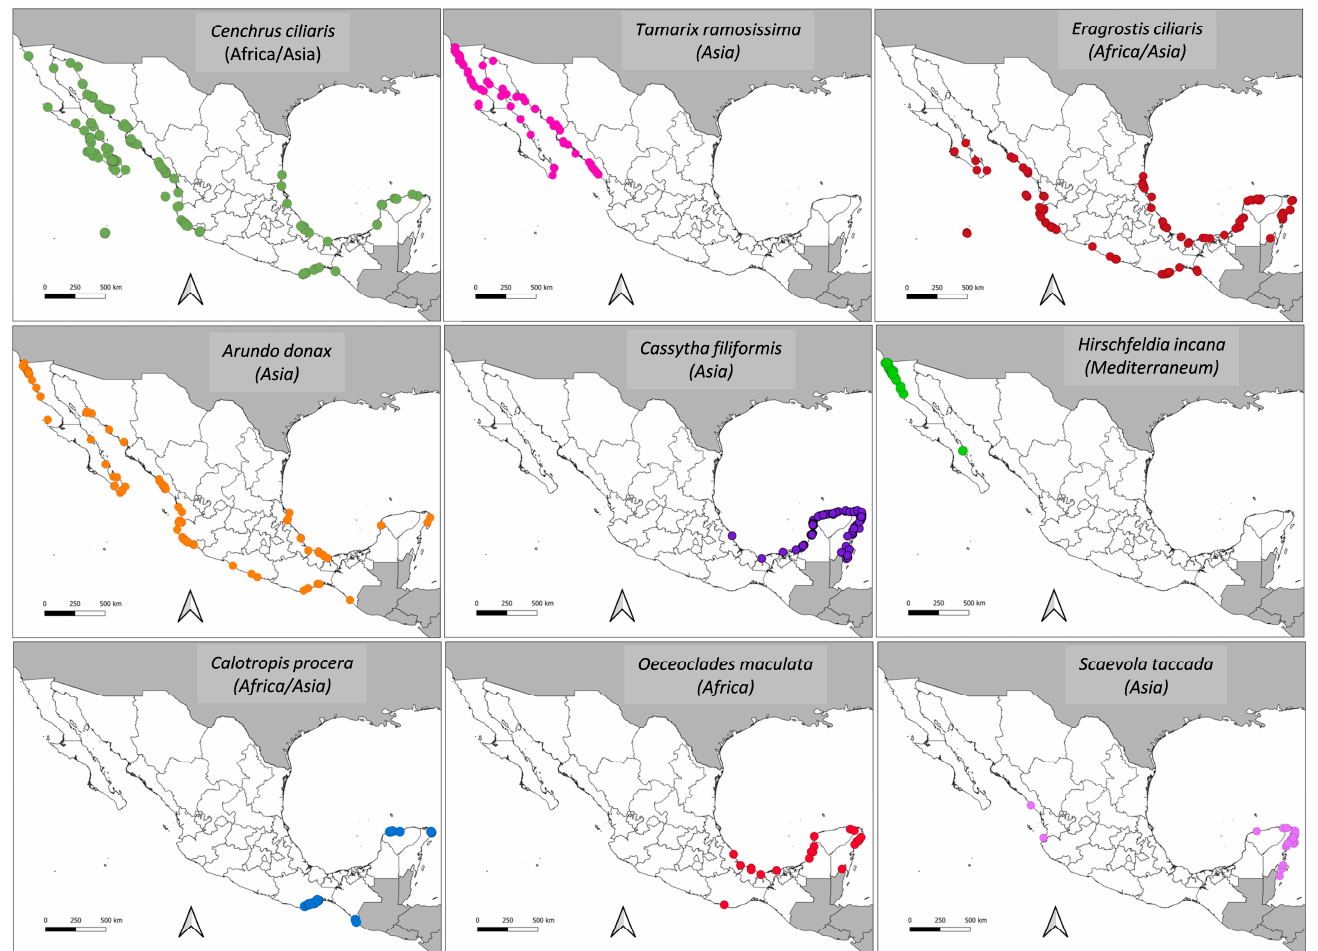
Figure 4. Geographic distribution and origin of the acknowledged invasive plant species found on Mexican coastal dunes. Maps elaborated by the authors using information from National System of Information on Biodiversity [29], the Project “Flora of the beaches and coastal dunes of Mexico” [30], updated by [5] and the database of EncicloVida [31].